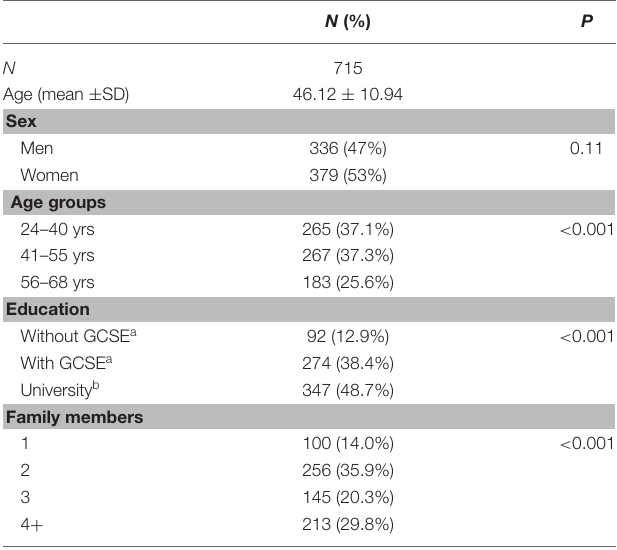
TABLE 2 | Demographic characteristics of the COVID-19 general population-based